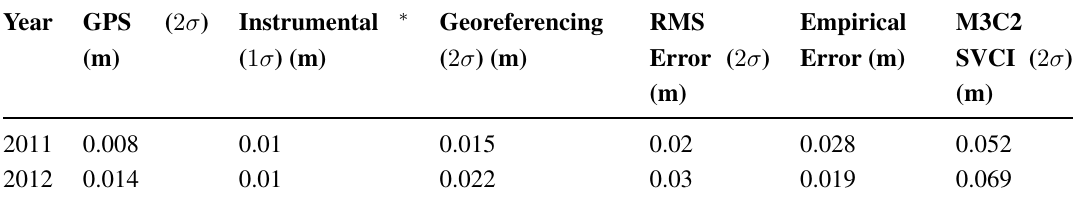
Table 1. Data used with Equation (1) and the resulting RMS error estimate. Registration errors in 2012 necessitated the use of a surface matching algorithm to re-georeference a portion of the point cloud data, which resulted in a larger georeferencing error. The 2012 GPS error is also larger than the 2011 GPS error. M3C2 spatially variable confidence interval (SVCI) values are the averages of the confidence intervals computed for all displacements by the algorithm. ∗ Instrumental error provided by the manufacturer lists the error as 0.005 m at 100 m [55]; however, the slump headwall is, on average, 200 m from the instrument, so the published value was doubled for this